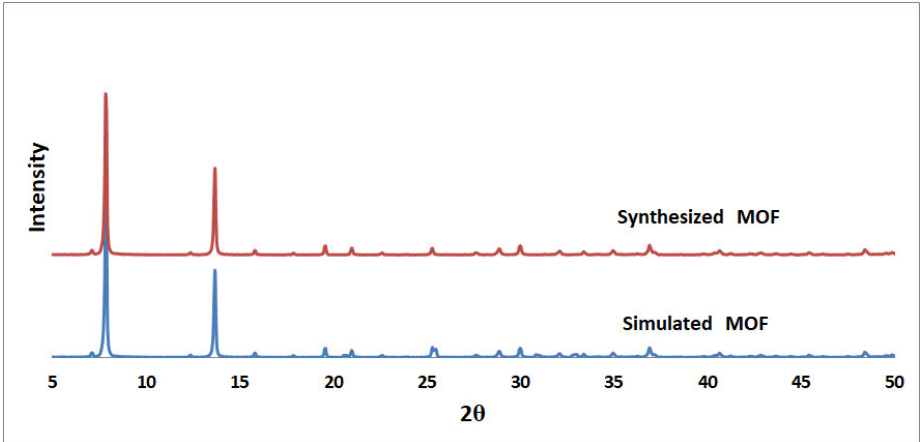
Figure 4. XRD pattern of synthesized Ni-MOF-74 in compared with simulated MOF [48].